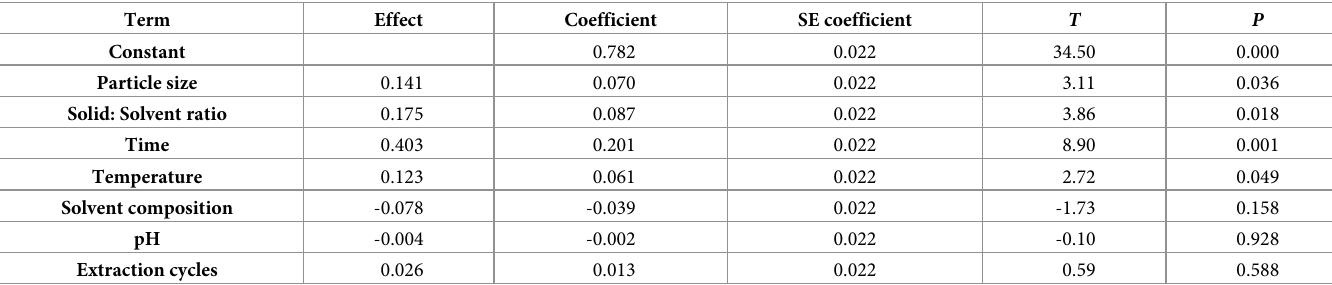
Table 4. Regression analysis for prediction of significant extraction parameters by PBD